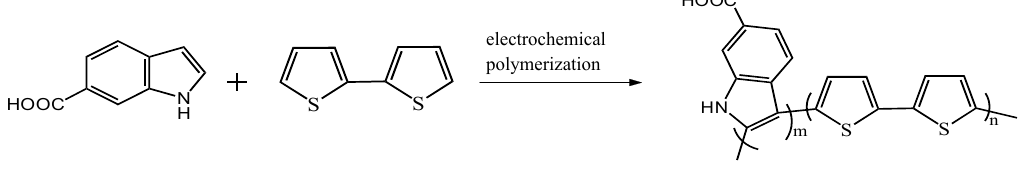
Figure 5. Figure 4. The electrochemical polymerization scheme of P(Inc- co -bT). The redox behavior of P(Inc- co -bT) film was studied using cyclic voltammograms at scanning rates between 10 and 200 mV s − 1 in 0.2 M LiClO 4 /(PC+ACN) solution, and the results are shown in Figure 5. Figure